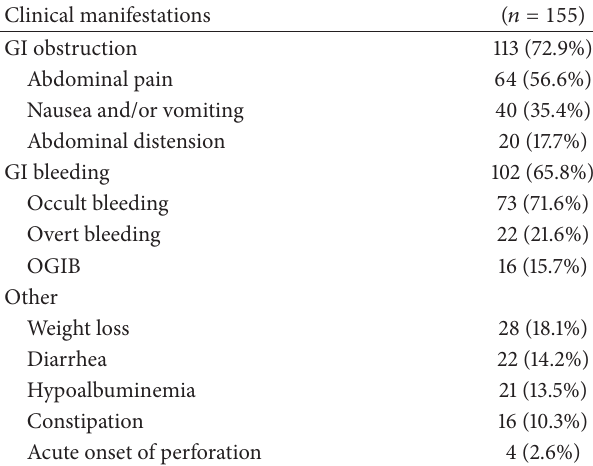
Table 1: Clinical manifestations in patients with NSAIDs-induced DD.